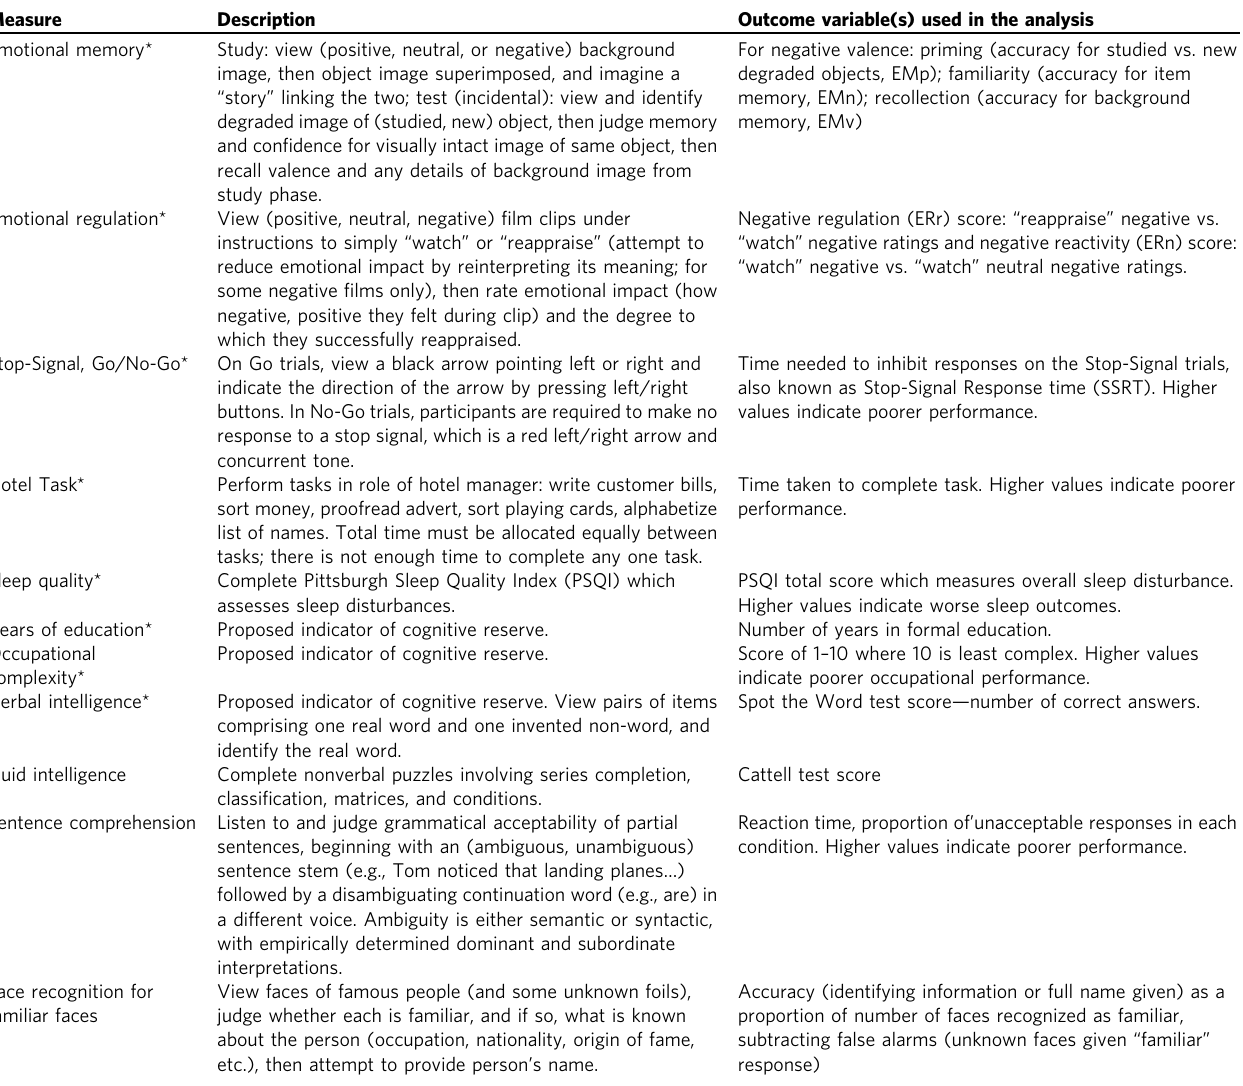
Table 4 Cognitive and behavioral measures from the Cam-CAN database proposed to rely on either NA-dependent or NA- independent processes (see ref. 32 for a full description of the measures) and included in the SEM analyses. Measure Description Outcome variable(s) used in the analysis Emotional